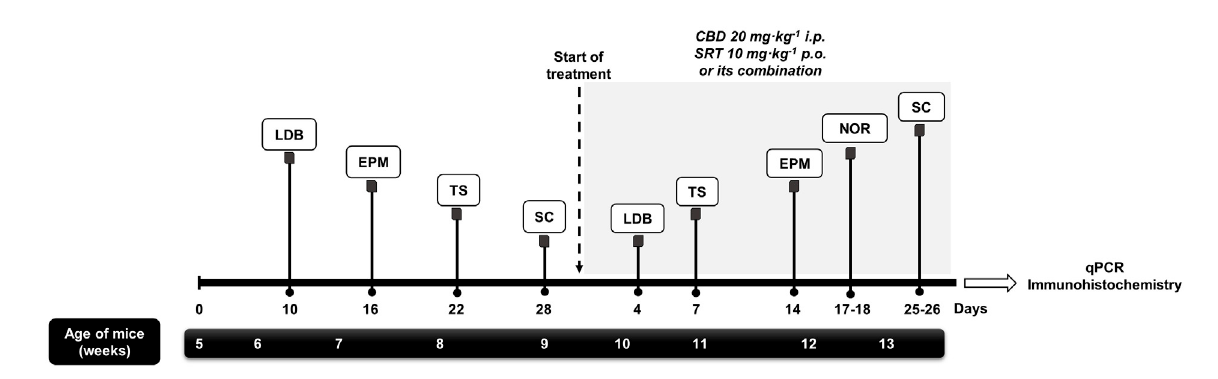
FIGURE 1 Schematic representation of the experimental design . Mice were exposed to the Unpredictable Chronic Mild Stress Model (UCMS) for 8 weeks. During the fi rst 4 weeks, the model was established, being behavioral alterations evaluated at 10, 16, 22 and 28 days by the light-dark box (LDB), elevated plusmaze(EPM), tailsuspension(TS)andsucroseconsumption(SC)tests,respectively.Oncethemodelwasestablished,miceweredistributedrandomly to receive CBD (20 mg · kg-1, i.p., twice daily, at 9.00h and 19.00 h), STR (10 mg · kg-1, p.o., once daily, at 9.00 h), their combination or VEH, during 28 days. The ef fi cacy of each treatment in modulating the effects of UCMS were evaluated at different time points by the LBD, TS, EPM, Novel Object Recognition (NOR) and SC tests. Finally, mice were decapitated or perfused to perform real-time PCR (qPCR) and immunohistological